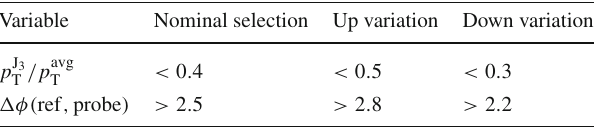
Table 1 Summary of the dijet topology selection and systematic vari- ations considered for the η -intercalibration analysis. The label J 3 refers to the third trimmed R = 1 . 0 jet in the event after ordering the jets in